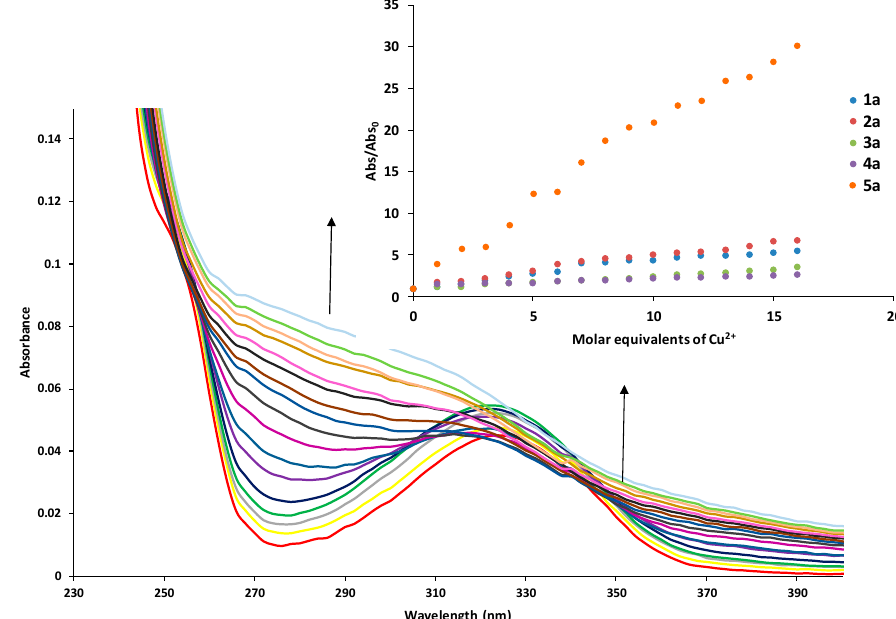
Figure 6. UV-Vis spectra obtained in the titration of decyl-derivative [1 × 10 − 5 M] and Cu 2 + [1 × 10 − 3 M]. In set normalized absorbance profiles obtained by the titration of the derivative with Cu 2 + , λ = 316 nm.